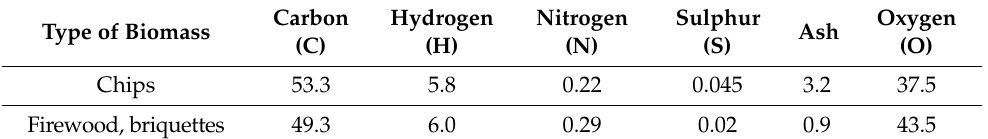
Table 1. Comparison of the composition of main elements for wood chips, firewood, and briquettes, %. Carbon Hydrogen Nitrogen Sulphur Oxygen Type of Biomass Ash (C) (H) (N) (S) (O) Chips 53.3 5.8 0.22 0.045 3.2 37.5 Firewood, briquettes 49.3 6.0 0.29 0.02 0.9